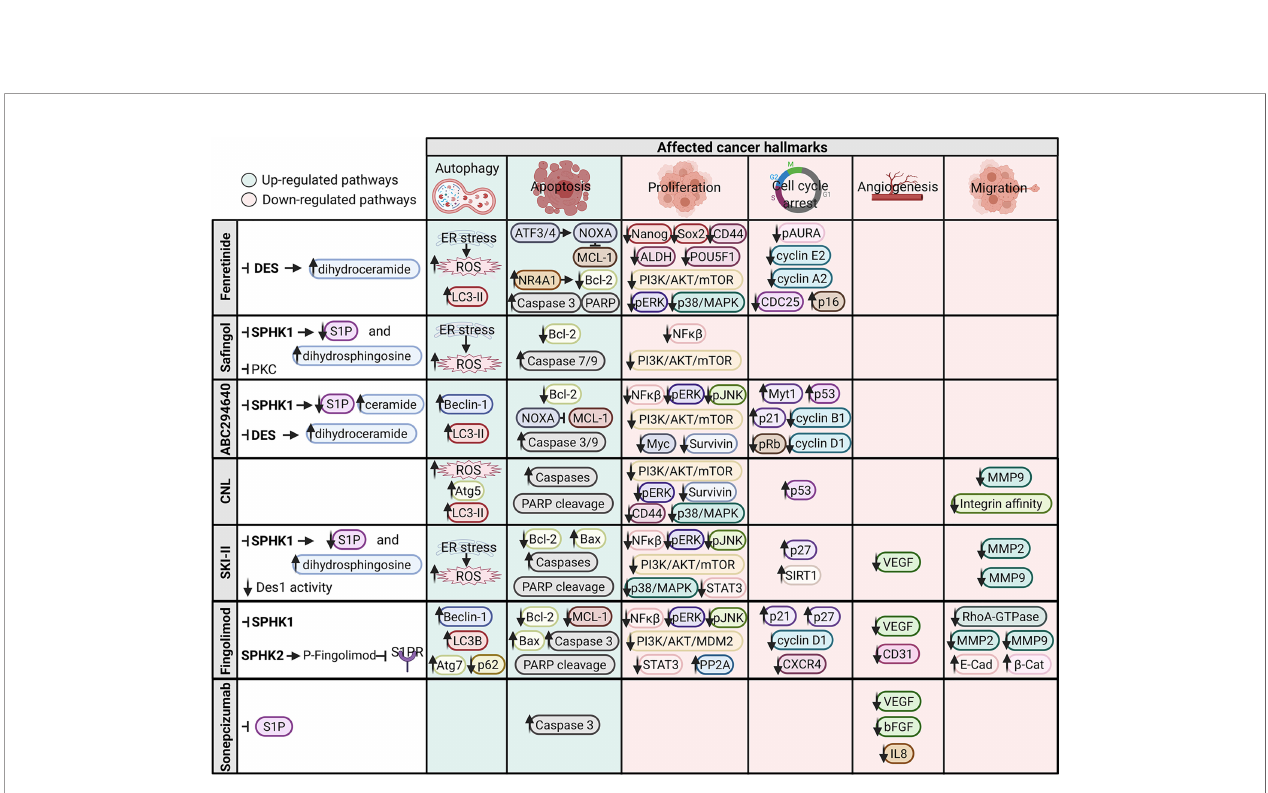
FIGURE 3 | Signaling pathways and cancer hallmarks affected by sphingolipid modulators. Upregulated pathways are indicated in green, and downregulated pathways are indicated in red. Figure created with BioRender.com.